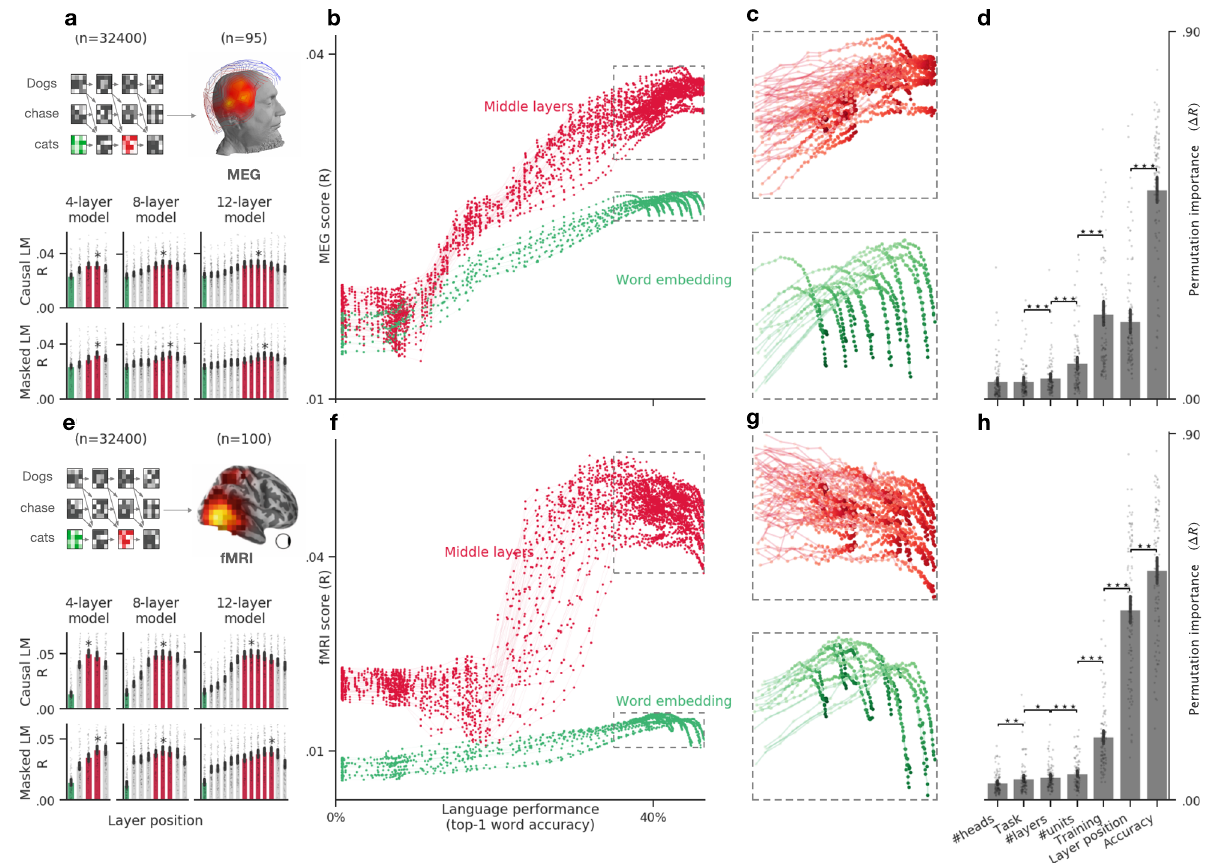
Fig. 4 Language transformers tend to converge towards brain-like representations. a Bar plots display the average MEG score (across time and channels) of six representative transformers varying in tasks (causal vs. masked language modeling) and depth (4 – 12 layers). The green and red bars correspond to the word-embedding and middle layers, respectively. The star indicates the layer with the highest MEG score. b Average MEG scores (across subjects, time, and channels) of each of the embeddings (dots) extracted from 18 causal architectures, separately for the input layer (word embedding, green) and the middle layers (red). c Zoom of b , focusing on the best neural networks (i.e., word-prediction accuracy >35%). The results reveal a plateau and/or a divergence of the middle and input layers. d Permutation importance quanti fi es the extent to which each property of the language transformers speci fi cally contribute to making its embeddings more-or-less similar to brain activity ( Δ R ). All properties (training task. dimensionality etc .) signi fi cantly contribute to the brain scores ( Δ R > 0, all p < 0.0001 across subjects). Ordered pairwise comparisons of the permutation scores are marked with a star (* p < 0.05, ** p < 0.01, *** p < 0.001). e – h Same as a – d , but evaluated on fMRI recordings. All error bars are the 95% con fi dence intervals across subjects ( n = 95 for MEG, n = 100 for